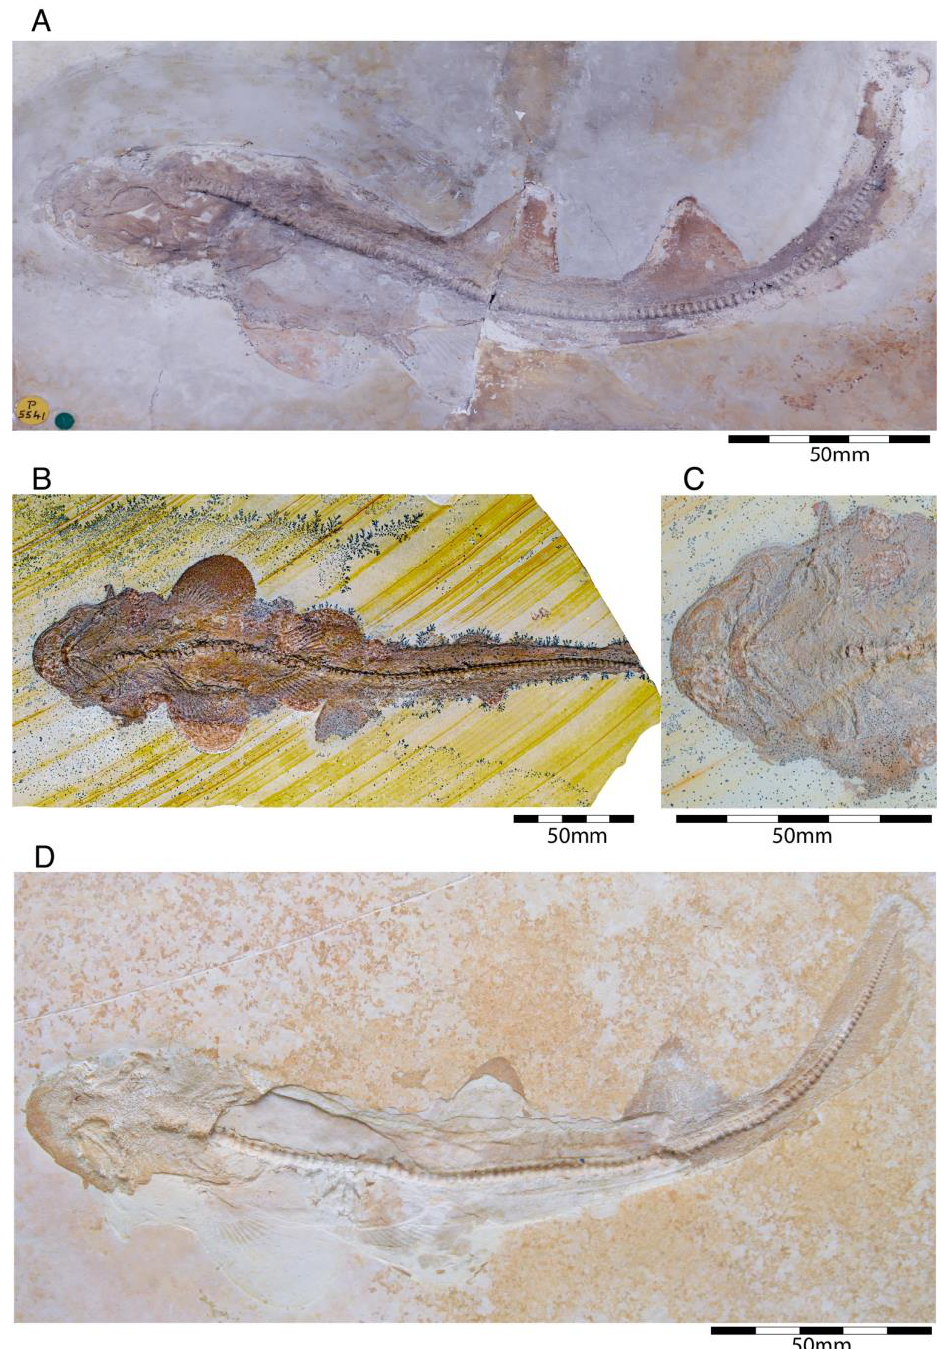
Figure 21. † Phorcynis catulina Thiollière, 1852 [229]. ( A ) Holotype specimen (NHMUK P 5541) from the lower Tithonian of Eichstätt. ( B ) Almost complete specimen (SNSB-BSPG 1990 XVIII 51) from the lower Tithonian of Zandt. ( C ) Close up to the cephalic region. ( D ) Holomorphic specimen (JME SOS 3150) from the lower Tithonian of Blumenberg.